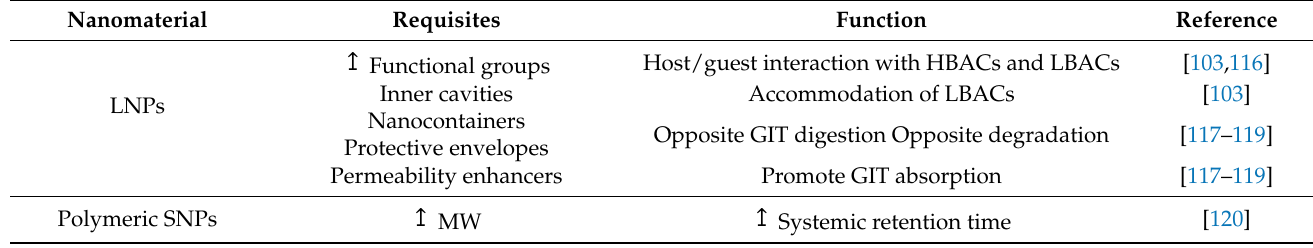
Table 8. Examples of nanosized formulations of BACs developed by using the abovementioned polymers. Table 9. Main properties and functions of organic SNPs.